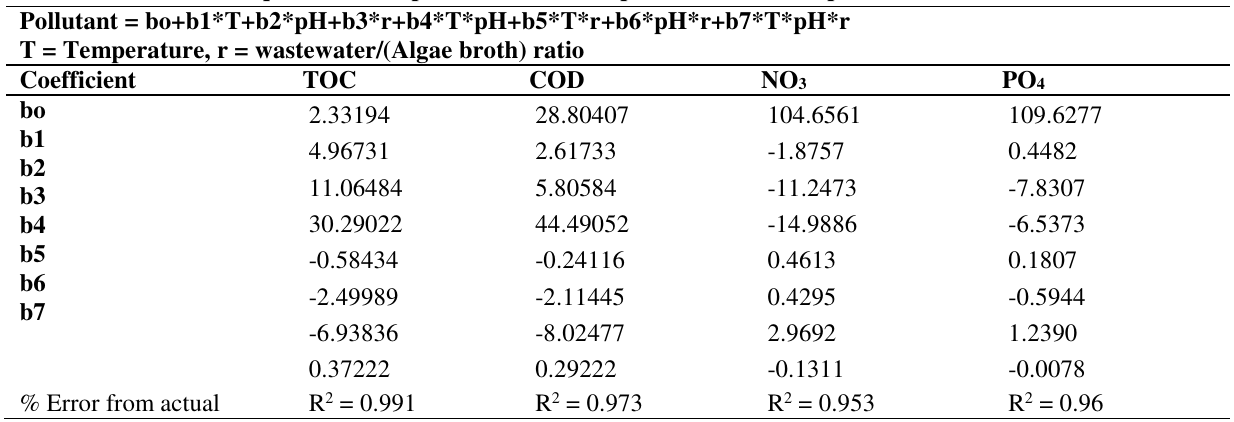
Coefficients for each equation of the predicted value for pollutants removal per